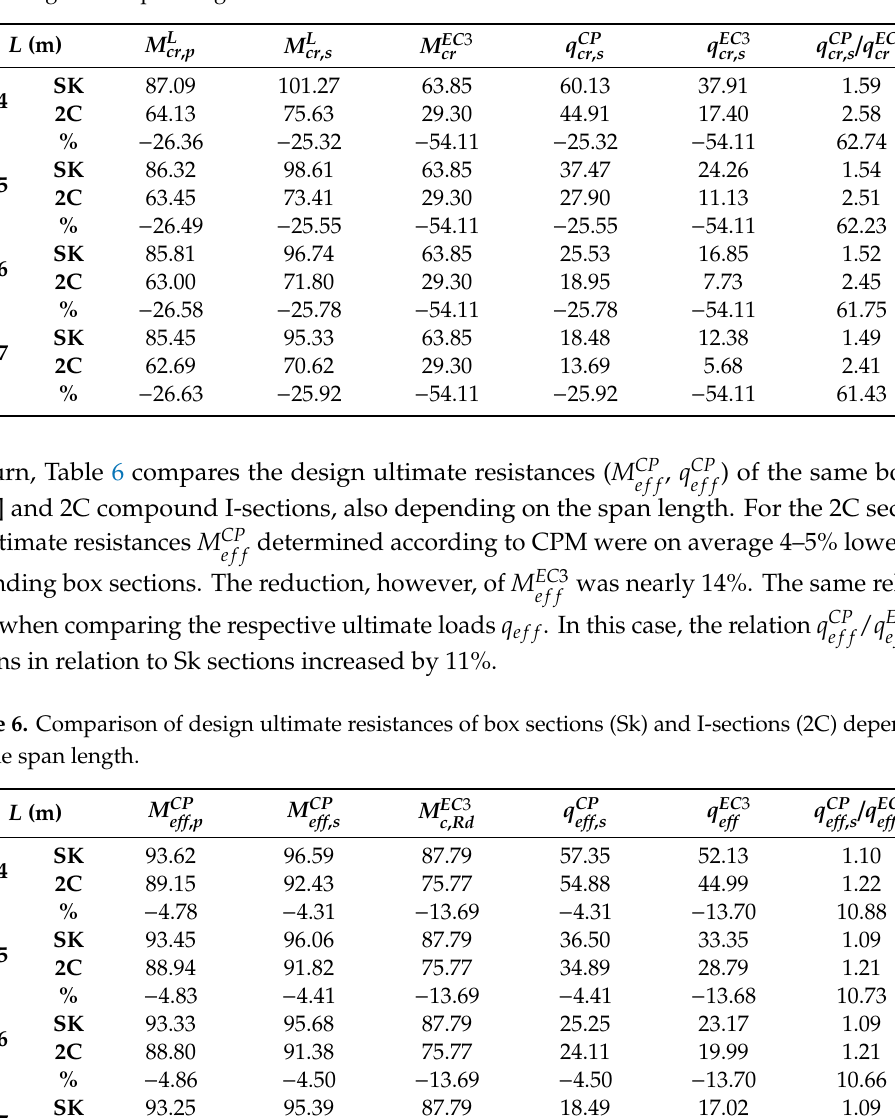
Table 5. Comparison of “local” critical resistances of box sections (Sk) and compound I-sections (2C) depending on the span length.